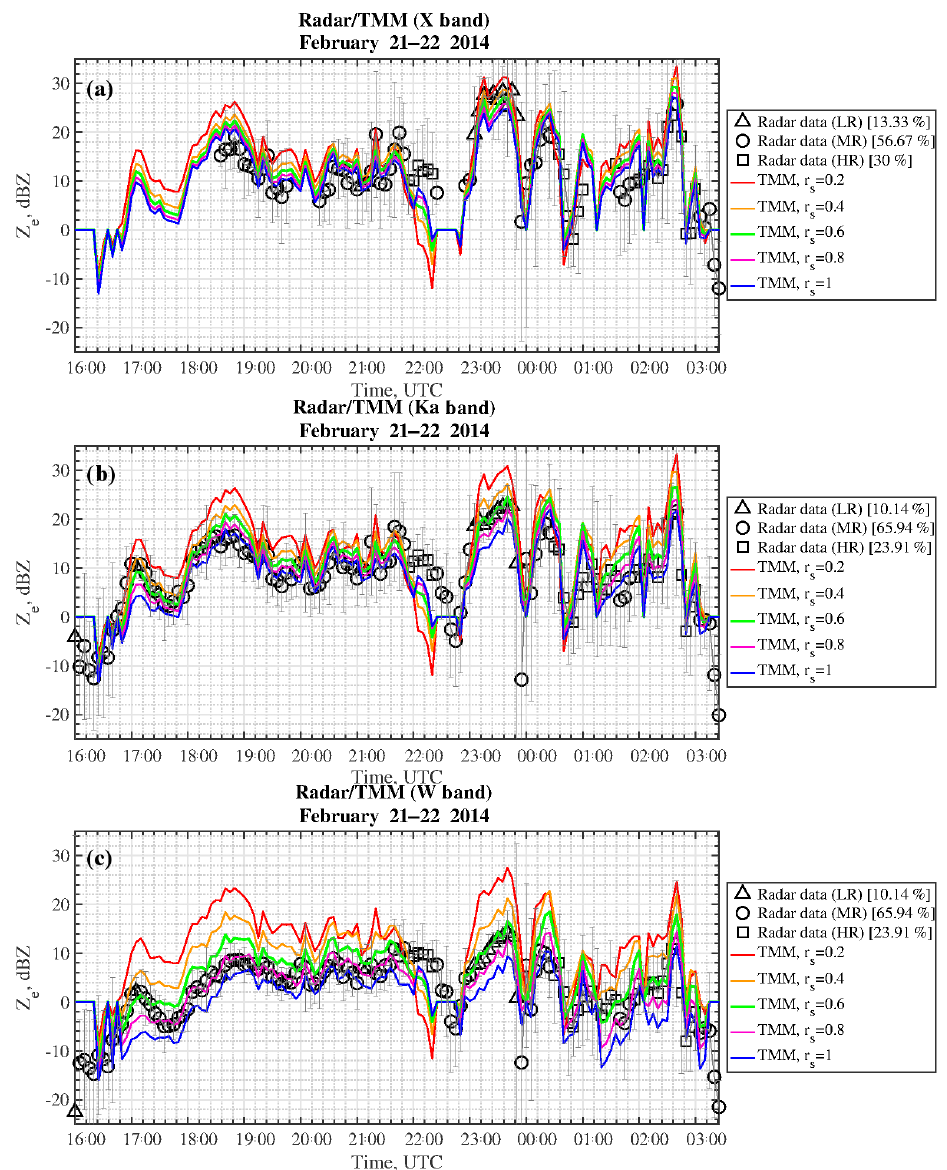
Figure 10. Same as Fig. 8, but for 21/22 February 2014, 16:00–03:24UTC (LR, MR and HR snowfall in black triangles, circles and squares,